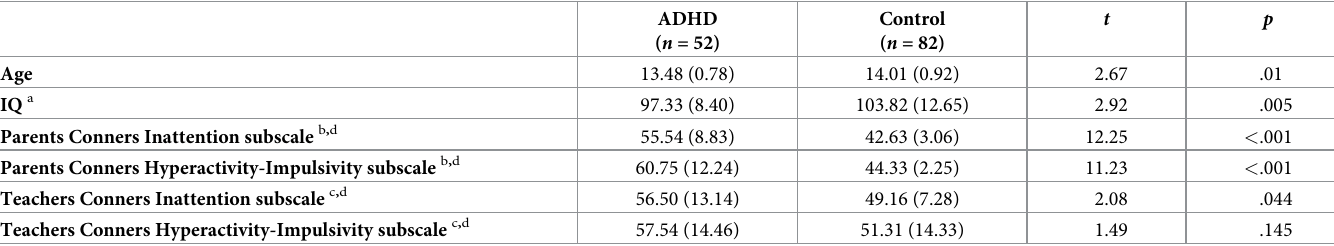
Table 1. Summary statistics and mean comparisons for age, IQ and ADHD measures adjusted for